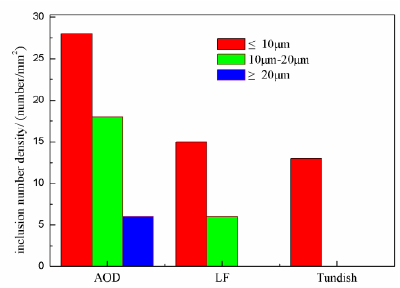
Figure 3. Size distribution of inclusions at different sampling locations.